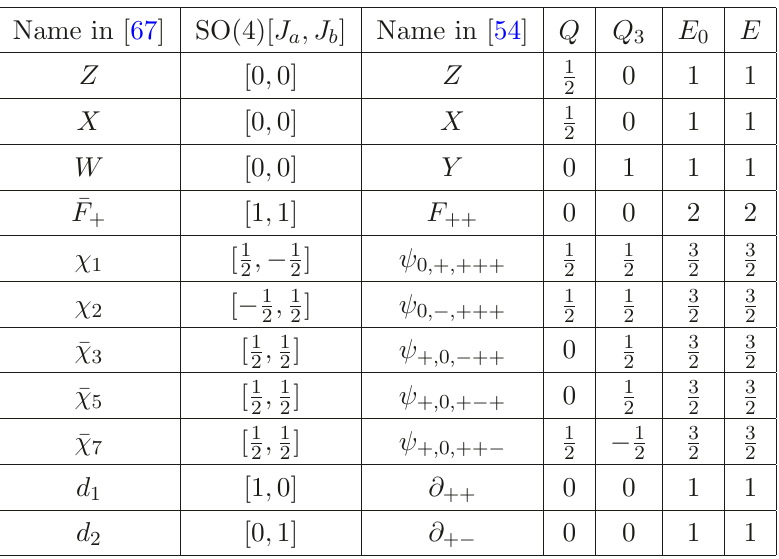
Table 1 . The single letter operators making up 1/16 th BPS operators in [54] correspond to the single letter operators comprising the SU(1 , 2 3) subsector as defined in [ 67, 68]. They satisfy the | E = E 0 BPS condition, where E 0 is the BPS value E 0 = J a + J b +2 Q + Q 3 , J a = J 1 + J 2 , J b = J 1 J 2 − and 2 Q = Q 1 + Q 2 . Note that we are working with the SYM theory on S 1 S 3 , dual to AdS 5 in × global coordinates. In radial quantization, the states on S 3 are in one-to-one correspondence with the operators on R 4 made up from the letters in the